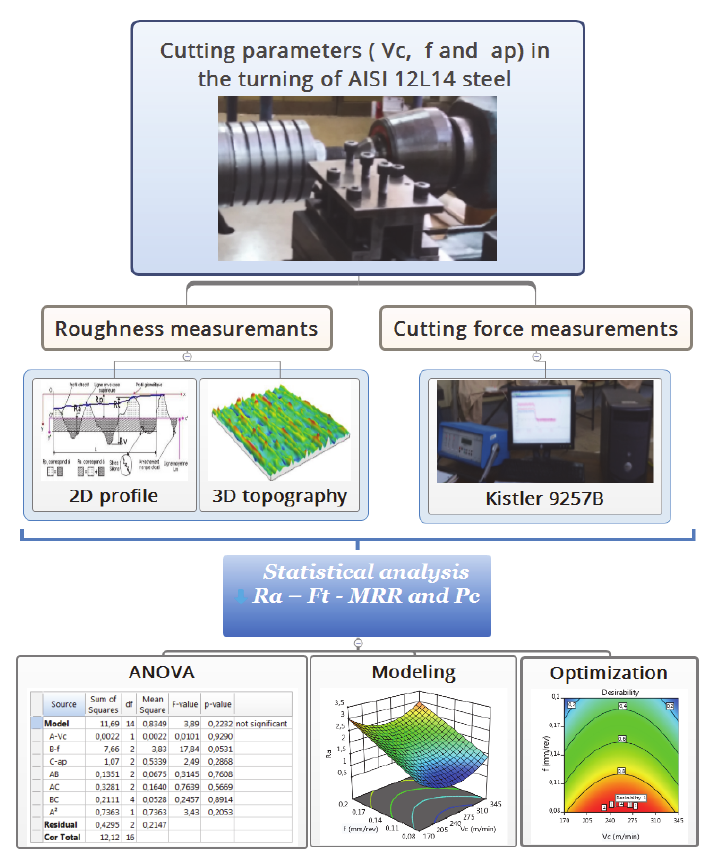
Fig. 3. Experimental procedure and data processing